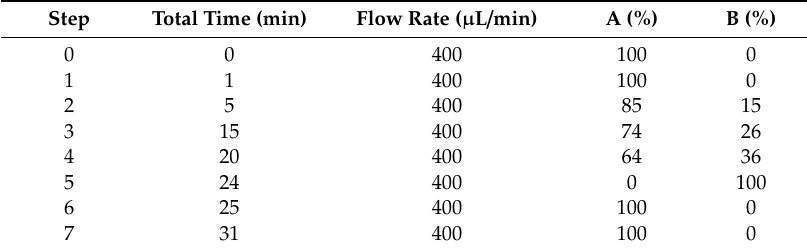
Table 3. Gradient